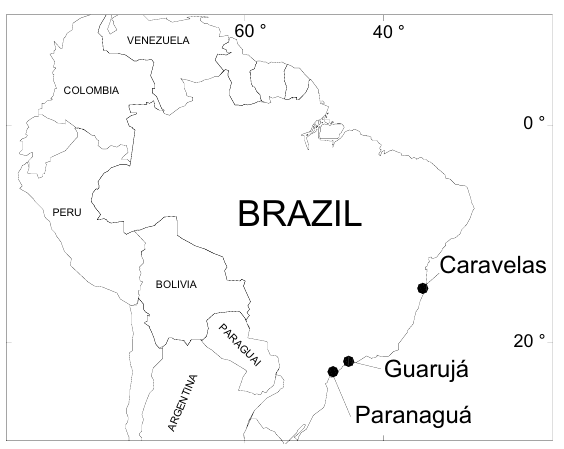
Fig. 1 – Location of the sites from where piezocone test results have been collected along the eastern Brazilian